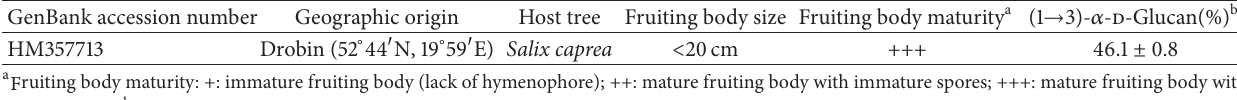
Table 1: Characteristics of harvested fruiting body of C. unicolor